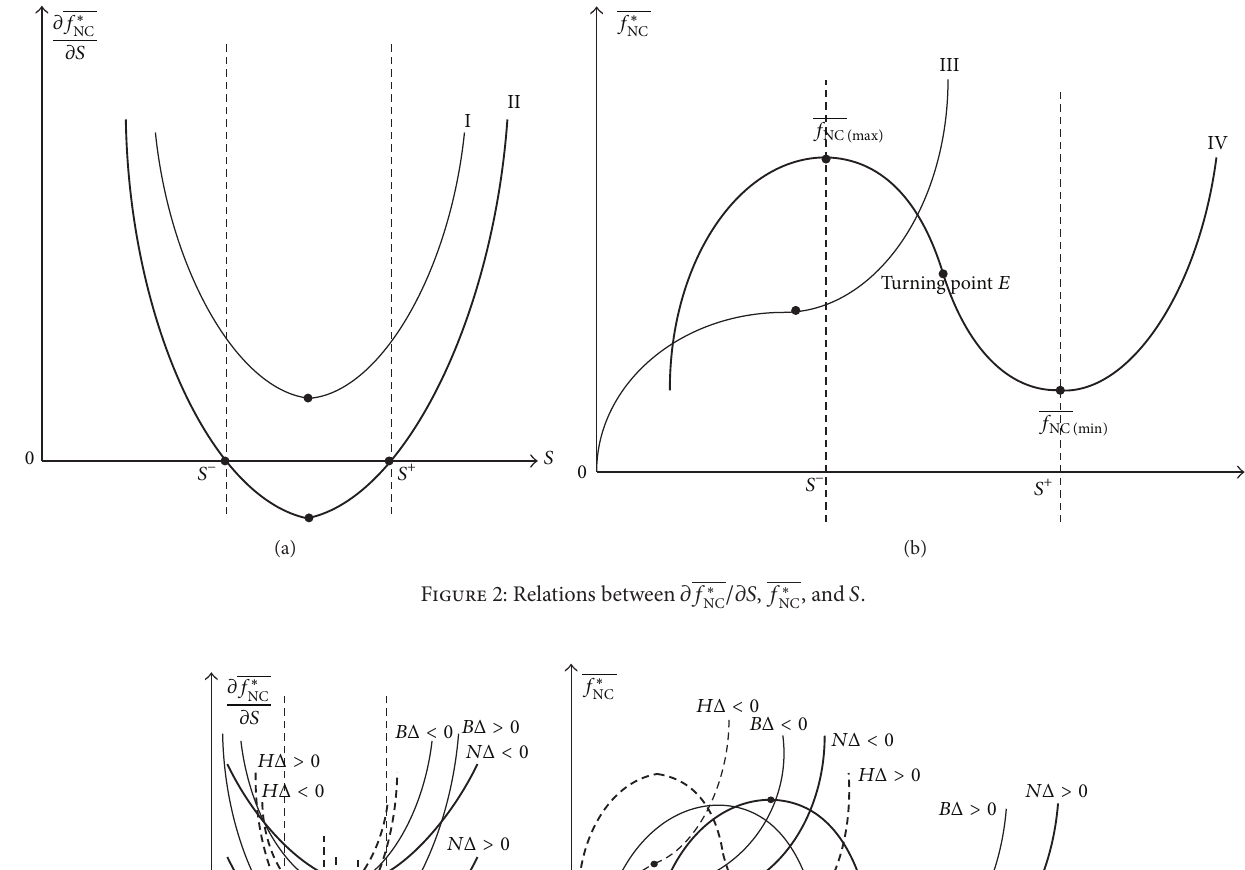
Figure 3: Relations between 𝜕𝑓 ∗ NC /𝜕𝑆 , 𝑓 ∗ NC , and 𝑆 in the conditions of three kinds of cooperation